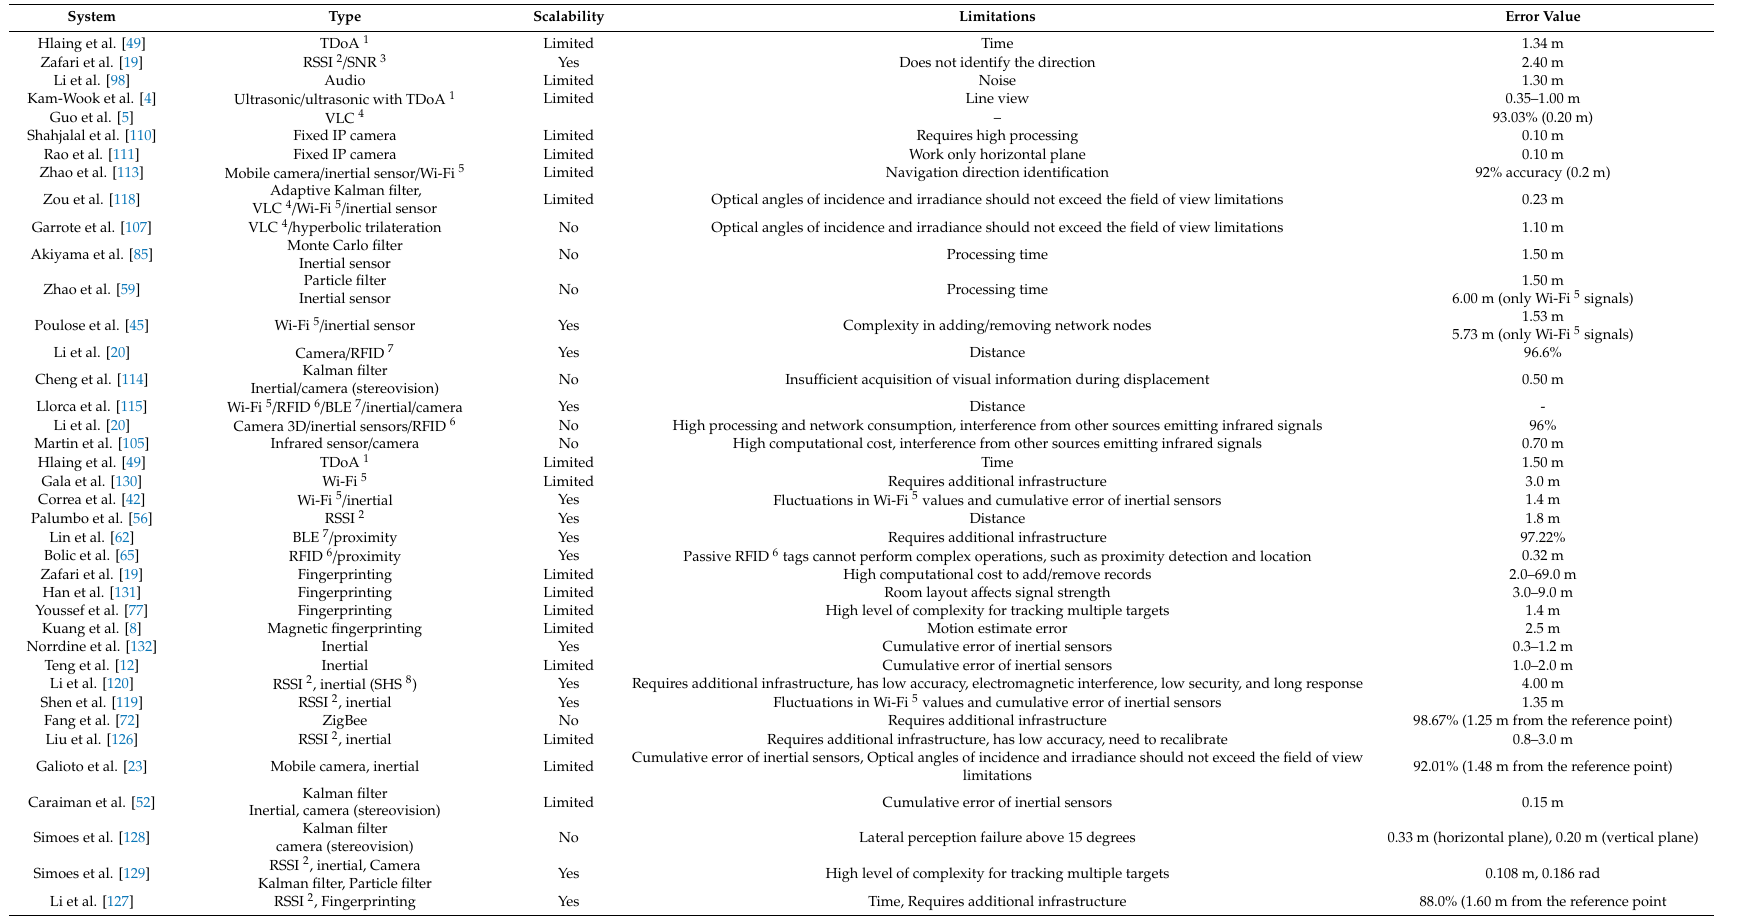
Table 1. Overview of indoor positioning